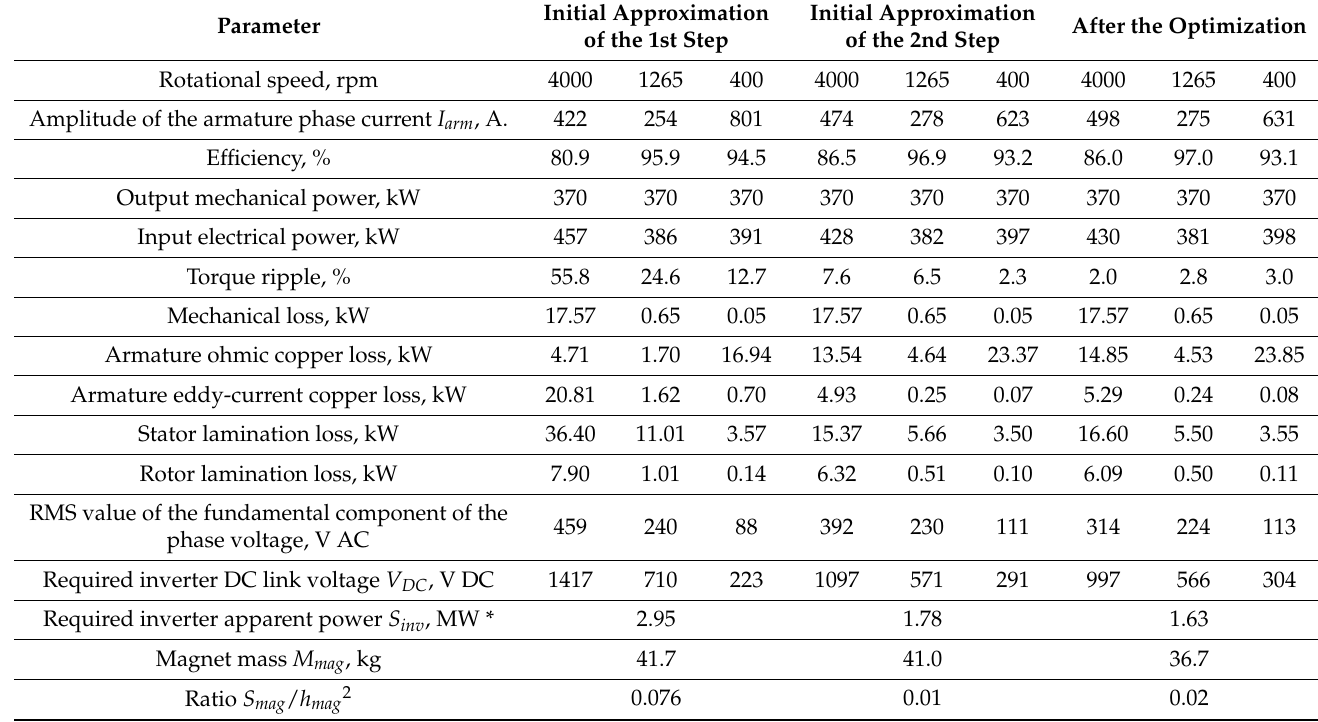
Table 4. Comparison of the IPMSM characteristics after different steps of the